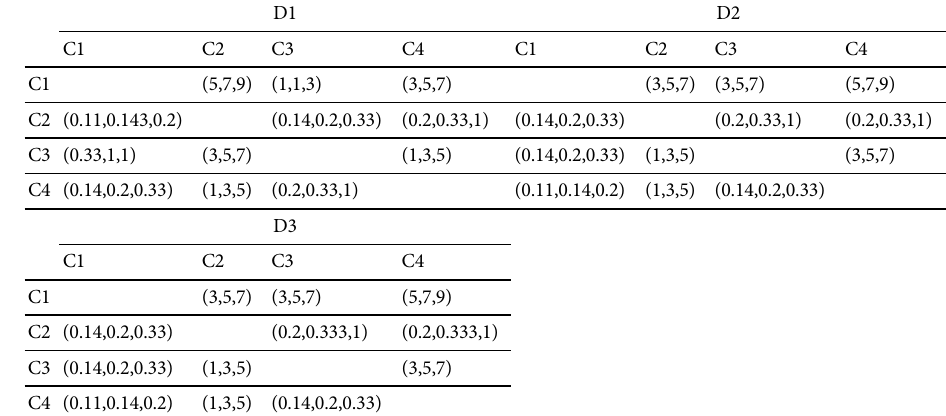
Table 4. Converted fuzzy numbers of DMs’ evaluations for